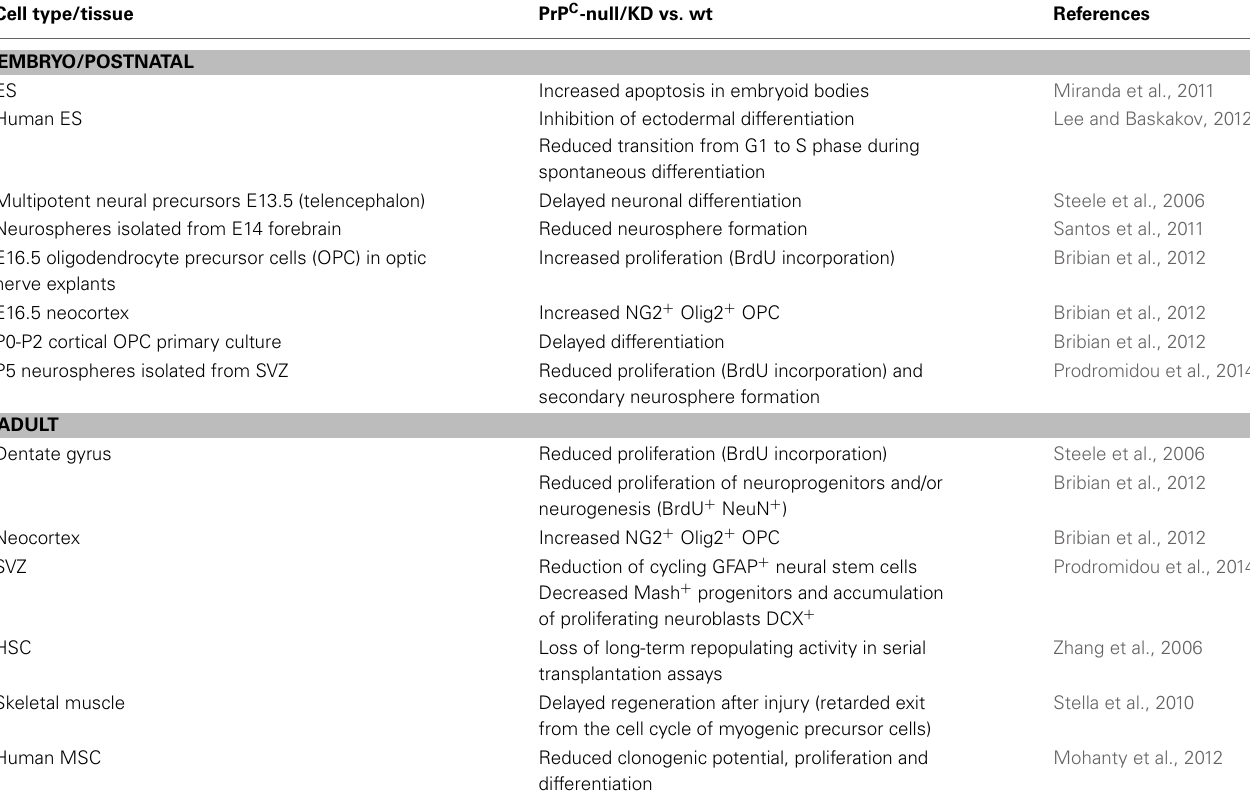
Table 1 | Summary of effects of PrP depletion on stem and progenitor cells.